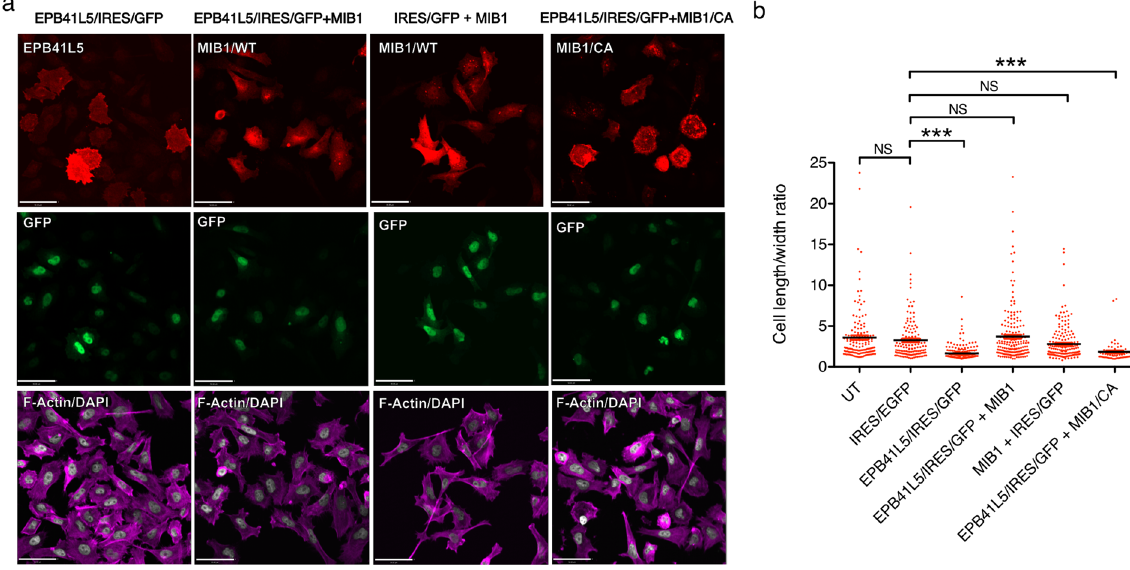
Figure 5. Co-expression of MIB1 prevents EPB41L5 mediated cell shape changes. ( a ) HeLa cells were transiently transfected with (images left to right): Flag-EPB41L5/pIRES/EGFP plus T7/pcDNA3.1, Flag- EPB41L5/IRES/EGFP plus T7-MIB1, T7-MIB1 with empty pIRES2/EGFP, or Flag-EPB41L5/IRES/GFP plus T7-MIB1 CA mutant. After 18 hours cells were trypsinized and reseeded onto fibronectin coated coverslips and allowed to adhere for 2 hours. Cells were fixed, permeablized, and immunostained with anti-FlagM2 (EPB41L5; CY3 anti-mouse, upper row, left), or anti-MIB1 (MIB1; CY3 anti-guinea pig, upper row, 3 right images), anti- GFP (co-expressed GFP; AlexaFluor 488 anti-rabbit, middle row), and Alexa Fluor 635 phalloidin and DAPI (F-actin and nuclei; lower row). Images were acquired at 20X magnification on a Quorum Spinning Confocal microscope and analysed using Perkin Elmer Volocity software. Scale bar is 50 μ m. Representative immunoblots showing protein expression are shown in Fig. S2. ( b ) Quantification of cell shape. The cell length to width ratio for each condition was measured: untransfected (UT: 152 cells over 4 experiments), empty IRES2/EGFP and T7/pcDNA3.1 vectors (137 cells over 3 experiments), EPB41L5/IRES/EGFP (219 cells over 4 experiments), EPB41L5/IRES/EGFP plus T7-MIB1 (186 cells over 4 experiments), IRES/EGFP plus T7-MIB1 (184 cells over 4 experiments) and EPB41L5/IRES/EGFP plus T7-MIB1 CA mutant (60 cells, 1 experiment). The summary graph shows individual cell measurements with their mean + / − SEM. for each condition. Statistical significance was measured using a One-Way ANOVA (Kruskal-Wallis) plus Dunn’s Multiple Comparisons test, p <